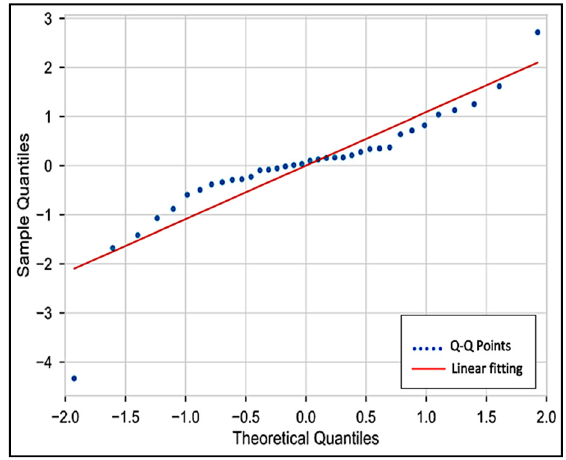
Figure 5. Normal Q-Q plot for the observed sample against theoretical quantiles.